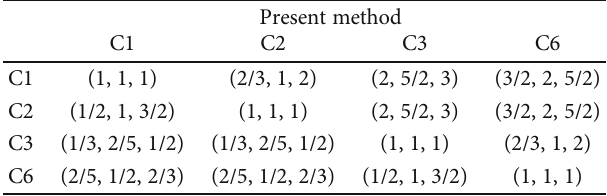
Table 6: The comparison matrix with respect to the